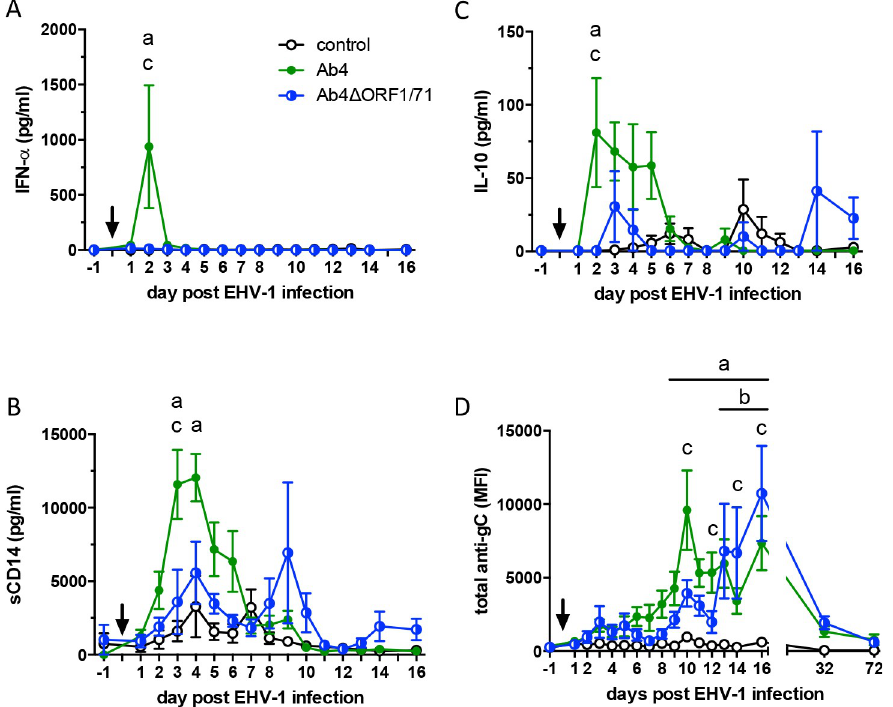
Fig 2. Cytokines and total anti-EHV-1 gC antibodies in nasal secretions of na ï ve horses (n = 5 per group) after infection with EHV-1 strain Ab4 or its deletion mutant Ab4 Δ ORF1/71. Non-infected horses were kept as controls. The arrow marks the time of infection. Nasal secretion samples were collected before and at various times after infection. Cytokine concentrations were analyzed by a bead-based Cytokine Multiplex assay and antibodies were evaluated by EHV-1 multiplex assay: (A) IFN- α (B) sCD14, (C) IL-10, and (D) total anti-gC antibodies expressed as median fluorescence intensities (MFI). Mean and standard errors are displayed. Significant differences between groups: a = Ab4 vs. controls, b = Ab4 Δ ORF1/71 vs. controls, and c = Ab4 vs. Ab4 Δ